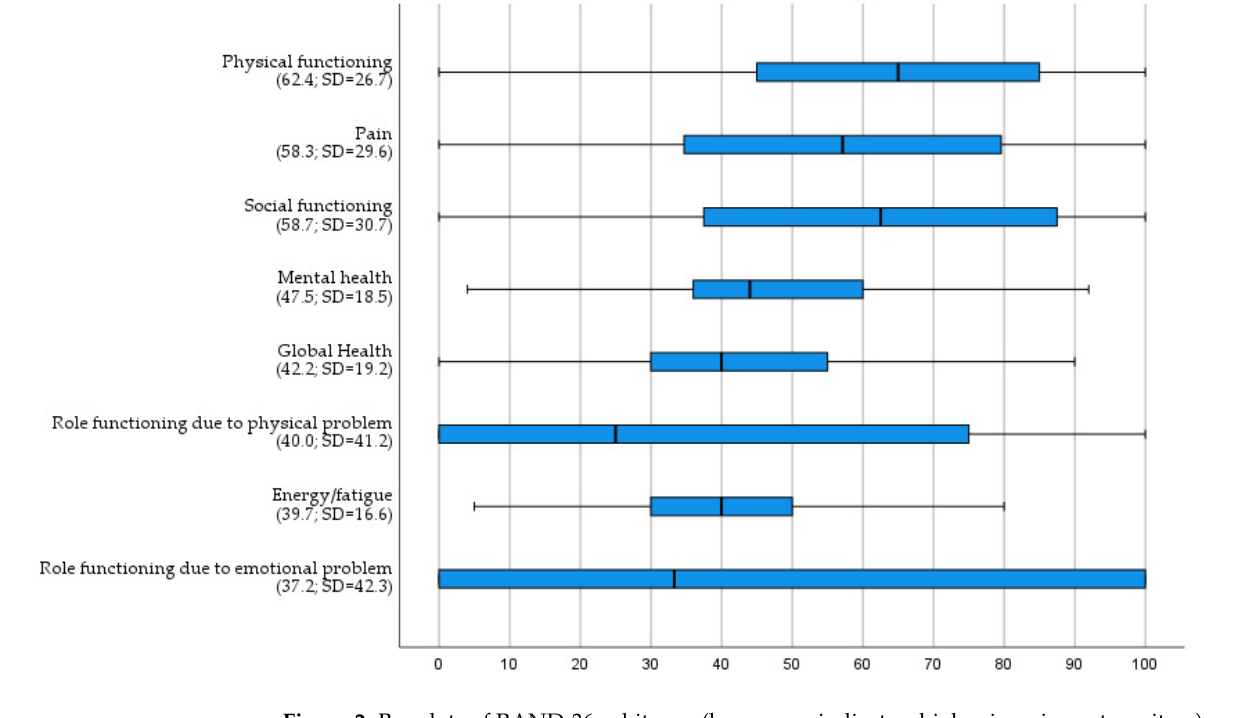
Figure 2. Boxplots of RAND-36 subitems. (low scores indicate a higher impairment per item).